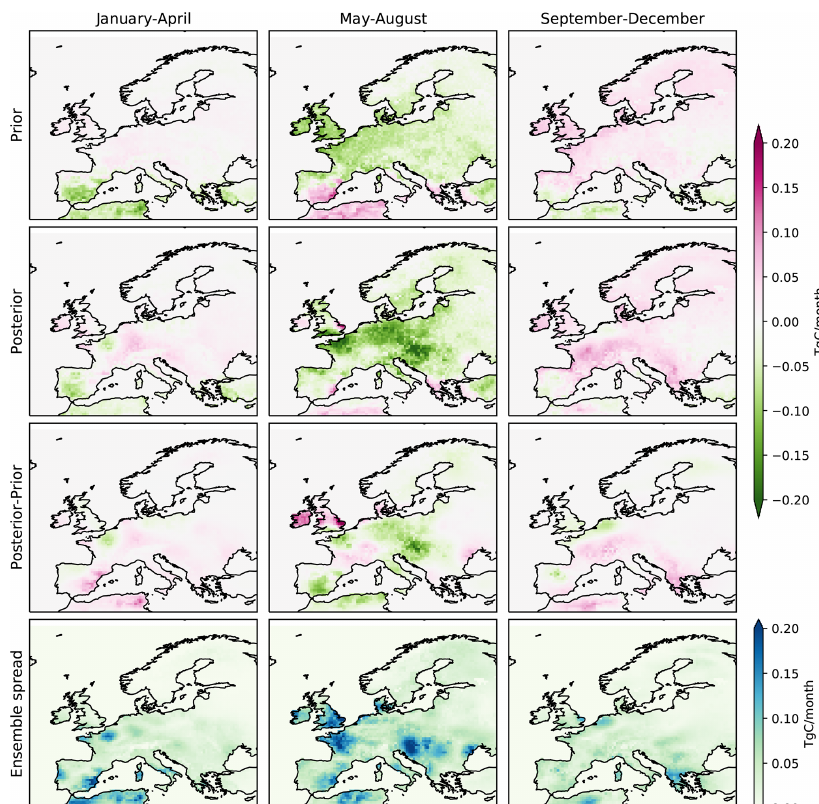
Figure 9. Total prior NEE (top), posterior NEE (second row) and NEE adjustment (third row) for the RRef inversion and for three 4-month periods (left to right); bottom row: posterior ensemble